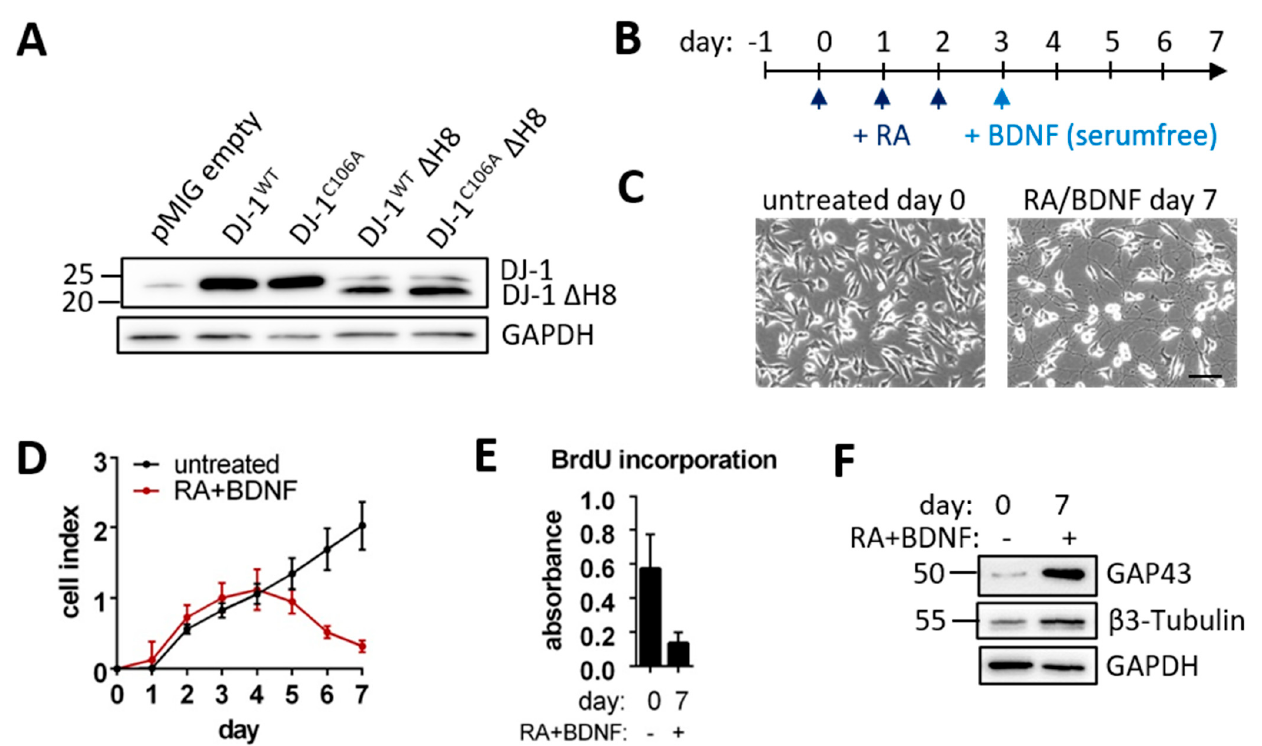
Figure 1. Established cell system: ( A ) DJ-1 Immunoblot of SH-SY5Y cells overexpressing different DJ-1 variants or pMIG empty vector ( B ) Timeline for SH-SY5Y differentiation with retinoic acid (RA) and brain derived neurotrophic factor (BDNF) ( C ) Micrographs of undifferentiated and differentiated SH-SY5Y cells (scale bar: 100 µm) ( D ) Real-time SH-SY5Y cell proliferation over 7 days of RA + BDNF treatment depicted as cell index over time of three technical replicates was assessed by absorbance at 370 nm ( E ) BrdU incorporation of untreated and RA + BDNF treated SH-SY5Y cells measured as the absorbance at 370 nm wavelength. ( F ) Immunoblots of mature neuronal markers Growth-associated Protein 43 (GAP43) and β -3-Tubulin with GAPDH as loading control.